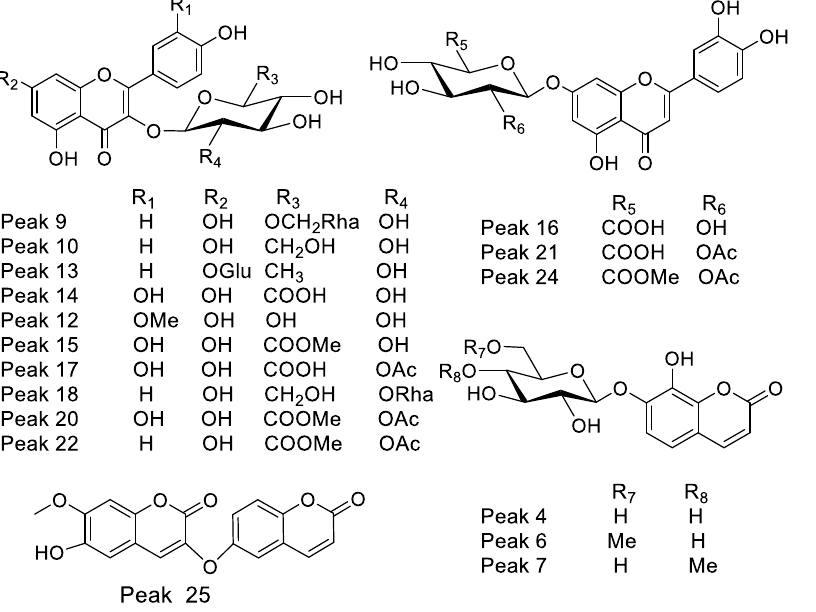
Figure 3. Main quercetin, kaempferol, luteolin and coumarin glycosyl derivatives detected in Lloime ( Ovidia pillopillo ) . ( Ovidia pillopillo